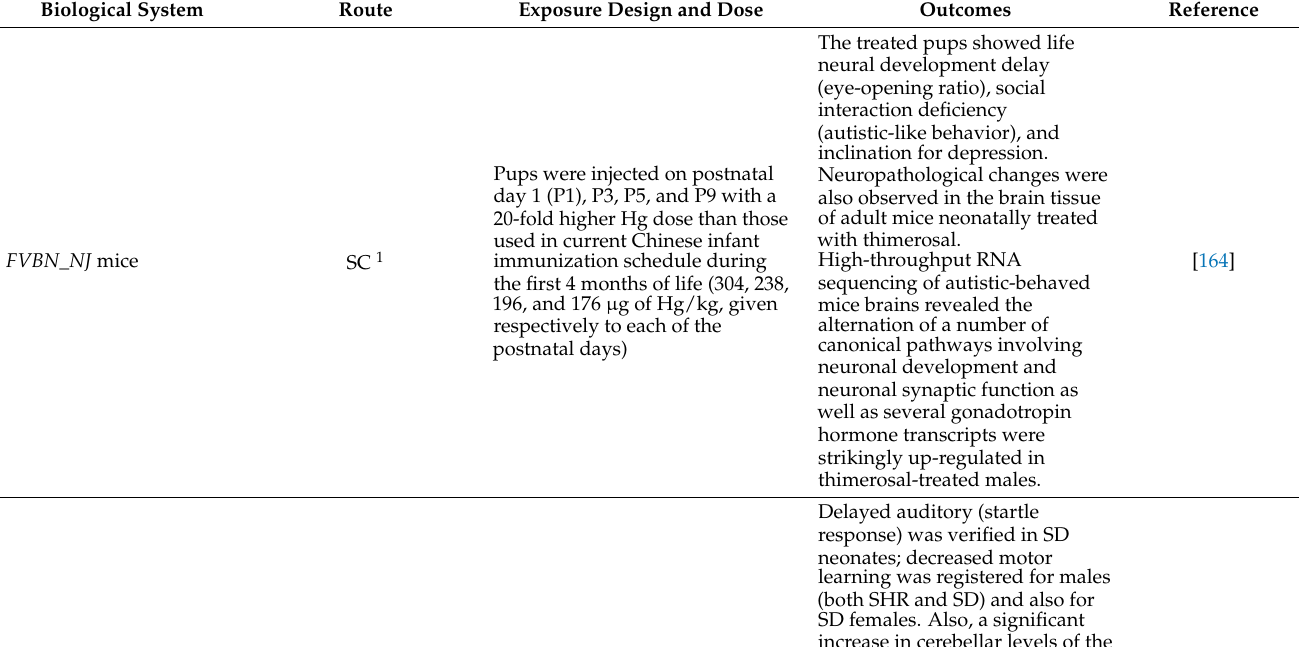
Table 1. Neurotoxic effects after in utero/perinatal exposure to thimerosal/EtHg through in vivo experimental